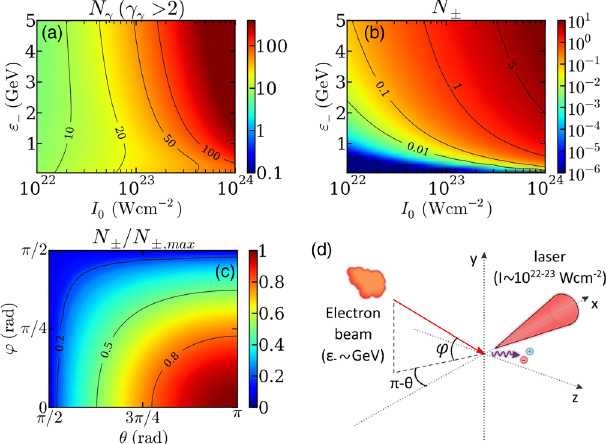
FIG. 2. Reduced kinetic-QED modeling: (a) Number of γ -ray photons of energies ε γ > 2 m e c 2 , N γ , and (b) of e − e þ pairs, N (cid:2) , produced during the entire laser interaction in the head-on collision of an electron with a laser plane wave (Gaussian temporal profile of 15-fs FWHM duration), as a function of the electron energy and laser intensity. (c) Ratio of the pair yield in an oblique collision over the pair yield in a head-on collision, N θ and φ . Contour lines are (cid:2) ; max , as a function of the angles shown as black curves in (a), (b), and (c). (d) Schematic of the electron-laser collision